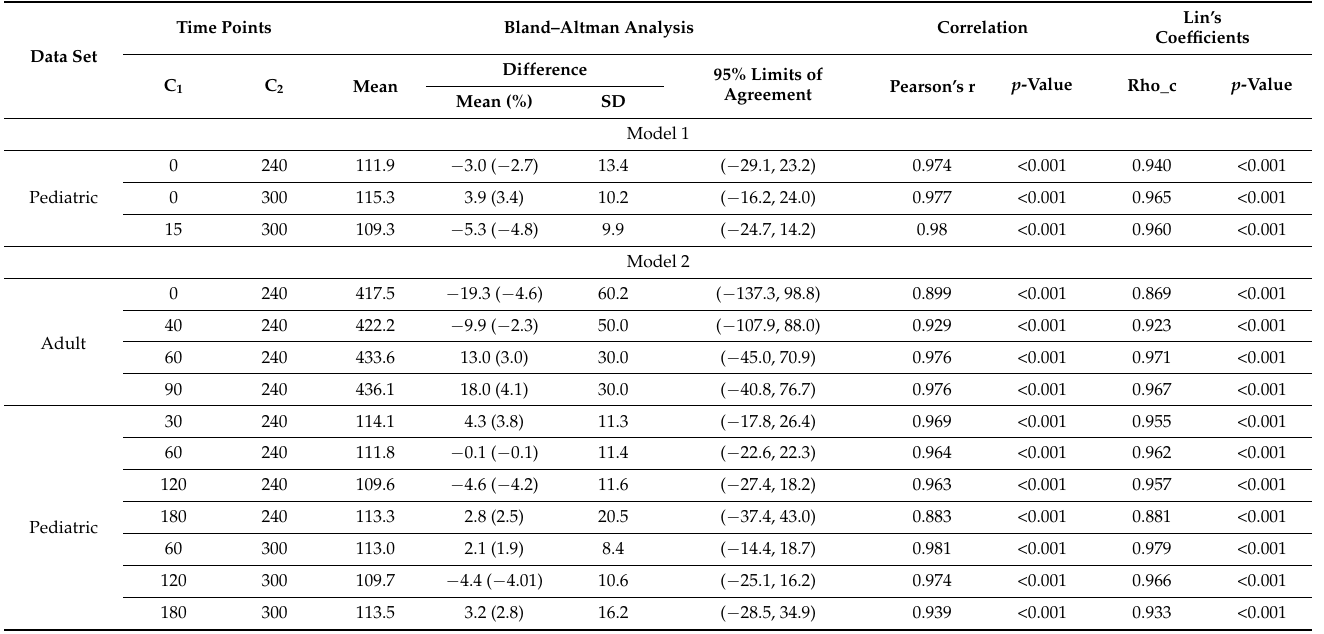
Table 1. Selected equation-paired concentration time points with an acceptable mean difference from the Bland–Altman analysis from adult and pediatric data